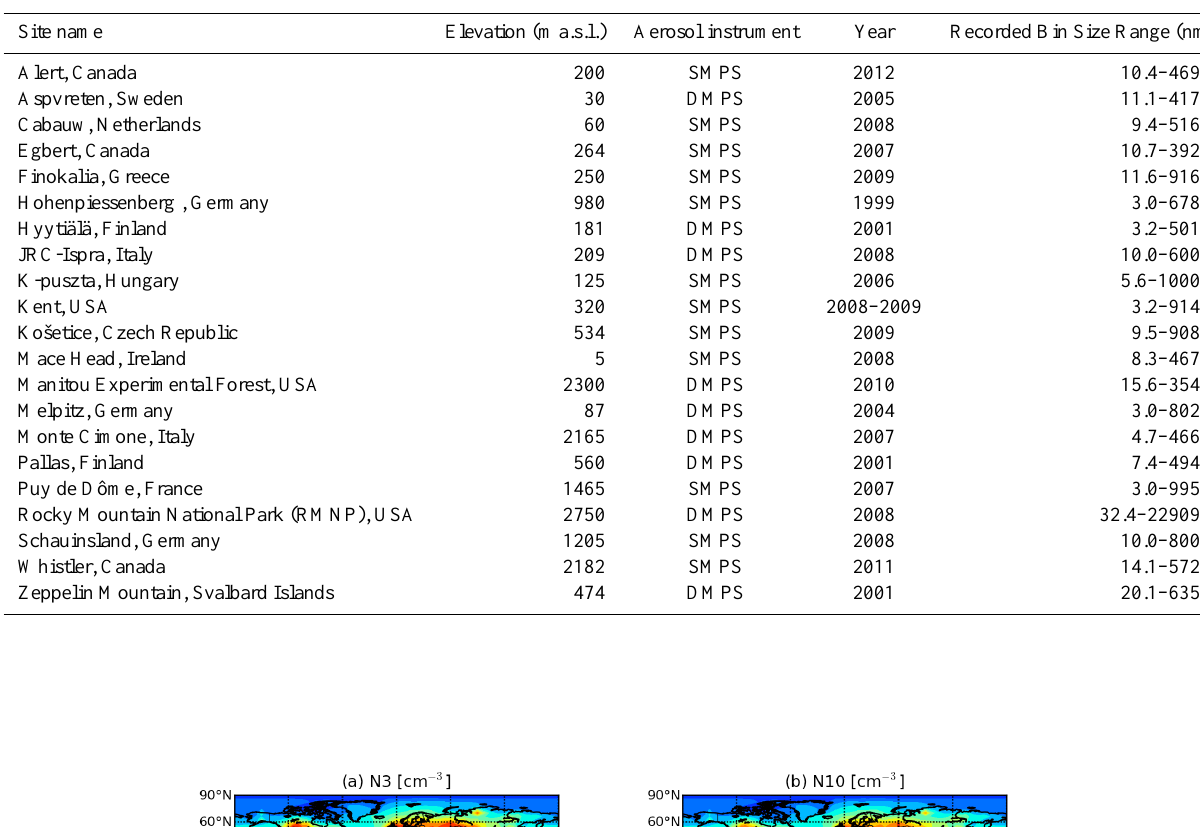
Table 2. Summary of surface observation sites used in this study compiled from the European Supersites for Atmospheric Aerosol Research (www.eusaar.net), from Environment Canada (Pierce et al., 2012; Riipinen et al., 2011), from the RoMANS 2 campaign (Levin et al., 2009), from the BEACHON campaign (Levin et al., 2012) and from Kent State University (Kanawade et al., 2012; Erupe et al., 2010). This summary is based on a similar surface observation site summary from Reddington et al. (2011). All date ranges except Kent are for one complete year.